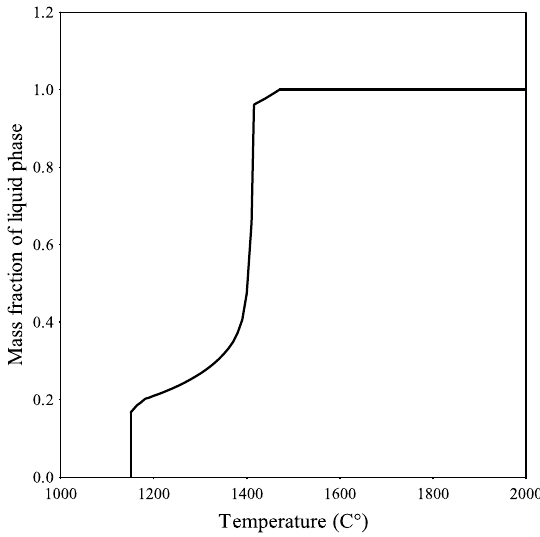
Figure 9. The mass fraction of liquid phase in the slags used in Trials 1 and 2 for a temperature span between 1000 and 2000 °C. The calculations were done by assuming an open system with an oxygen potential of 0.8.